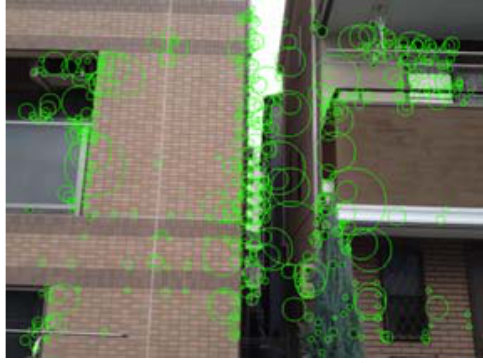
Figure 3. Feature points extraction by